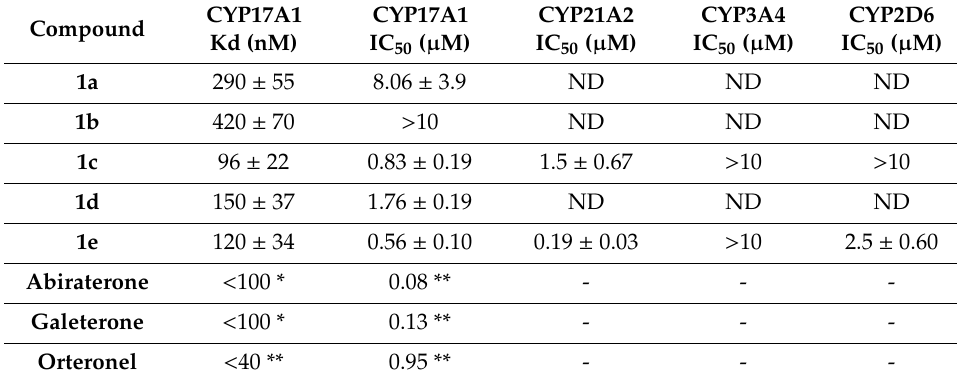
Table 1. Binding and enzyme inhibition; ND—not determined; *—data from Ref. [10], **—data from Ref.